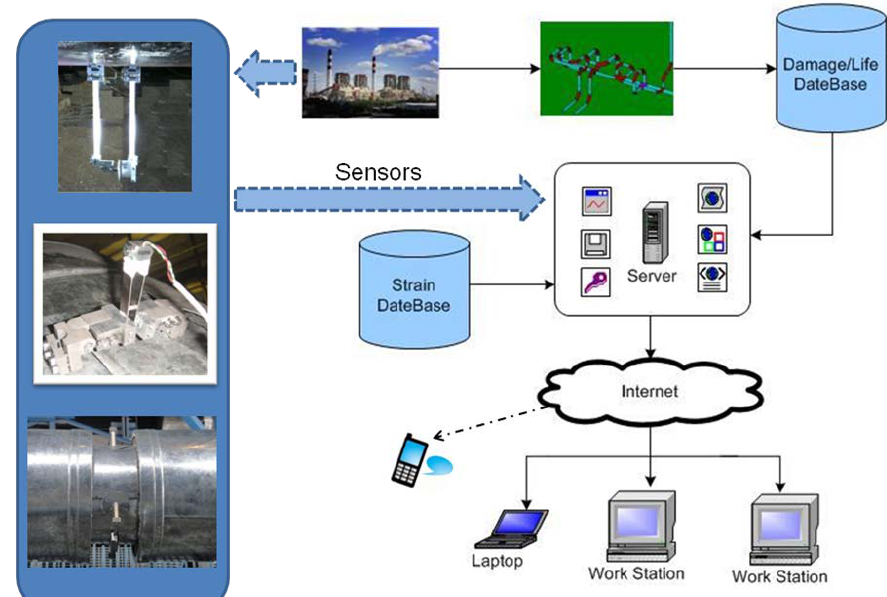
Figure 3. Modules of the monitoring